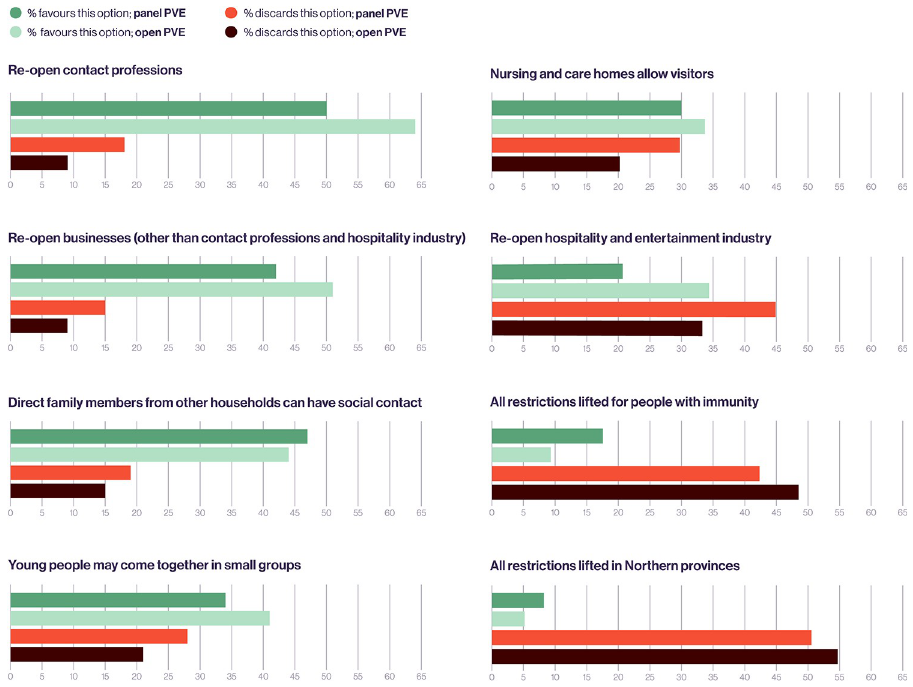
Fig 3. Percentage of respondents who recommended or opposed the eight relaxation measures.